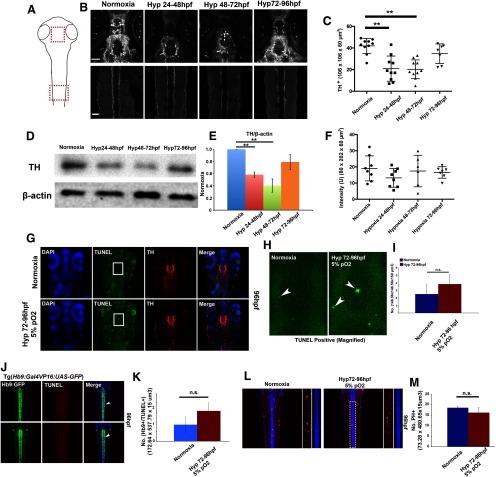
Hypoxia does not alter dopamine or motor neuron numbers, or axon pathfinding of the DDT after hypoxia from 3 to 4 dpf. A, Schematic drawing of regions imaged. Top, Diencephalon (for TH+ neurons). Bottom, Spinal cord (for DDT axons). B, Confocal images, z-stacks, maximum intensity projections, ventral views, rostral to the top; scale bars: 50 µm, anti-TH immunohistochemistry. C, Quantification of number of TH+ neurons in the diencephalon. D, Western blot analysis of whole zebrafish for anti-TH. E, Anti-TH quantification with SD; **p < 0.01. F, Intensity of DDT in the spinal cord shows no decrease following hypoxia. G, H, No increase in apoptosis posthypoxia in the diencephalon. Confocal images, z-stacks, maximum intensity projections, ventral views, rostral to the top, TUNEL labeling in green. I, Quantification with SD of apoptosis following hypoxia. J–M, No increase in apoptosis or proliferation posthypoxia in the spinal cord. Motor neurons identified by co-labeling with Tg(Hb9:GFP) line. Confocal images, z-stacks, maximum intensity projections, dorsal views, rostral to the top, TUNEL or PH3 (phosphohistone-3) labeling in red. Quantification with SD. n.s., not significant.